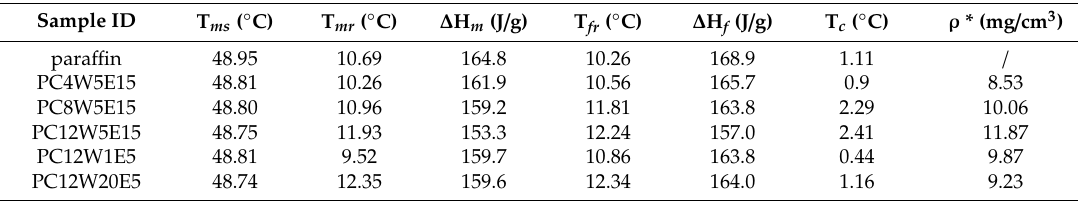
Figure 13. DSC curves of di ff erent AGA / para ffi n composites (( a ) was the complete curve, ( b ) and ( c ) were the local enlarged pictures of the melting and solidification curves respectively); Figure ( d ) compared the relevant thermal properties of samples with di ff erent GO concentrations and the same other conditions. Figure ( e ) compared the relevant thermal properties of samples with di ff erent microwave treatment times and the same other conditions. (T ms , the initial melting temperature; T mr , the melting range; ∆ H m , melting enthalpy; T fr , solidifying range; ∆ H f , solidification enthalpy; T c , subcooling degree. See Table 1 for specific values). Table 1. Temperature, Density and Enthalpy.